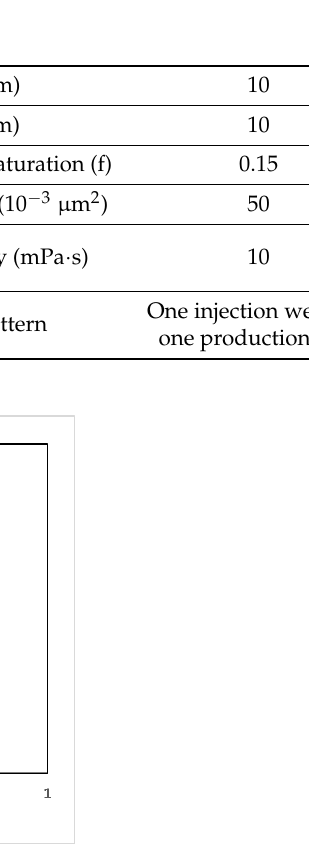
Figure 3. Relative permeability of three directions. Table 1. Simulation model parameters.